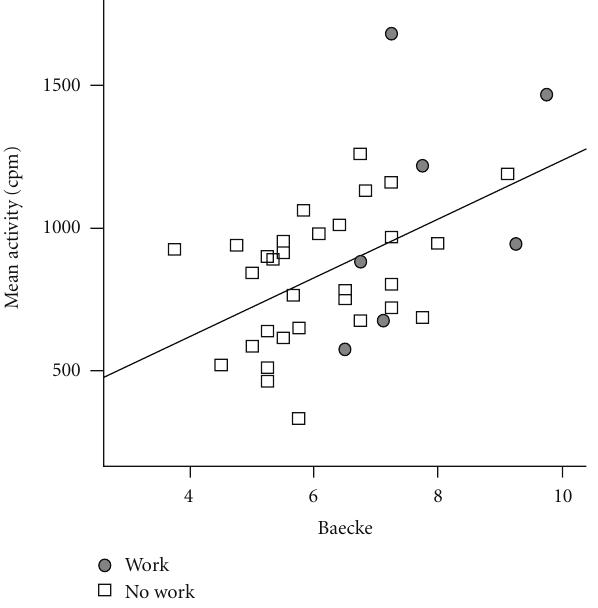
Figure 4: scatter plot of COPD patients for subjective activity (BPAQ) ( y -axis) and objective activity (accelerometer) ( x -axis), stratified for employment with linear trend